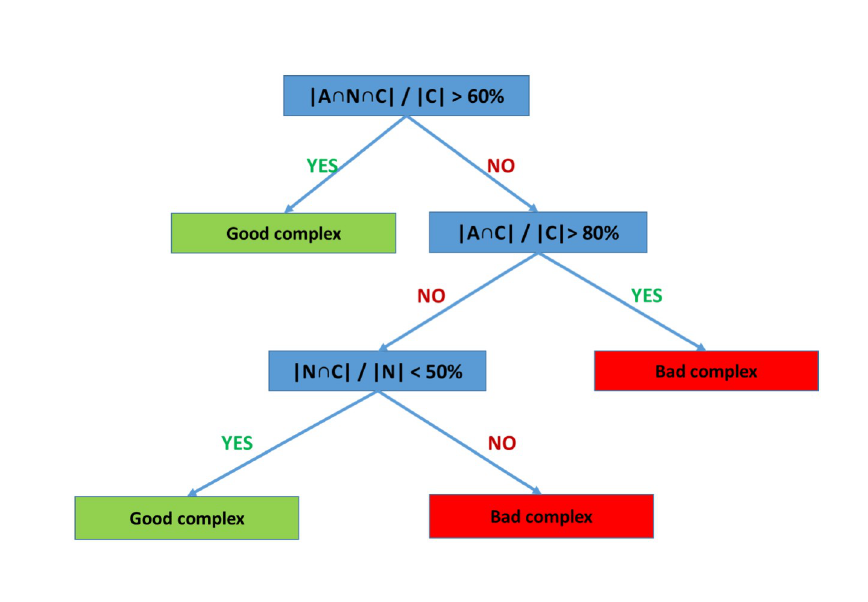
Fig 3. Decision tree for identification of low nanomolar cysteine protease–dipeptydil nitrile complexes on the basis of conformational space overlaps.